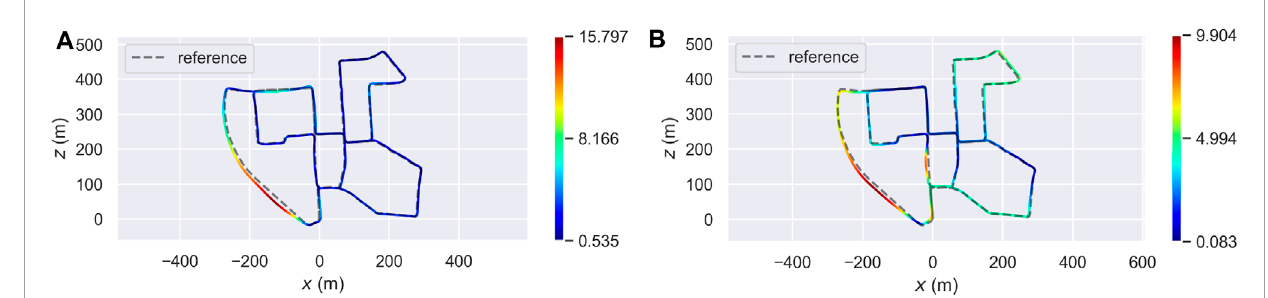
FIGURE 8 Localization accuracy of two proposed approaches (Prior SLAM on the left, Non-rigid SLAM on the right) on Sequence 07 of the KITTI odometry dataset Geiger et al. (2012). (A) Error distribution (Prior SLAM). (B) Error distribution (Non-rigid SLAM).